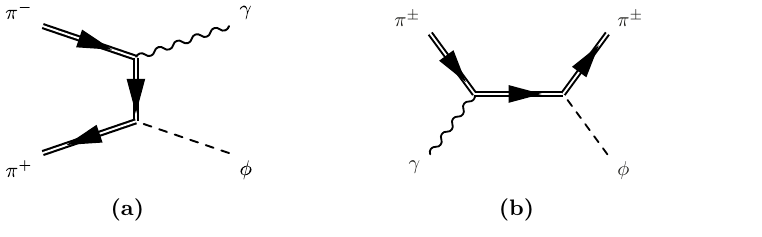
Figure 6. Examples of the production from mesons.